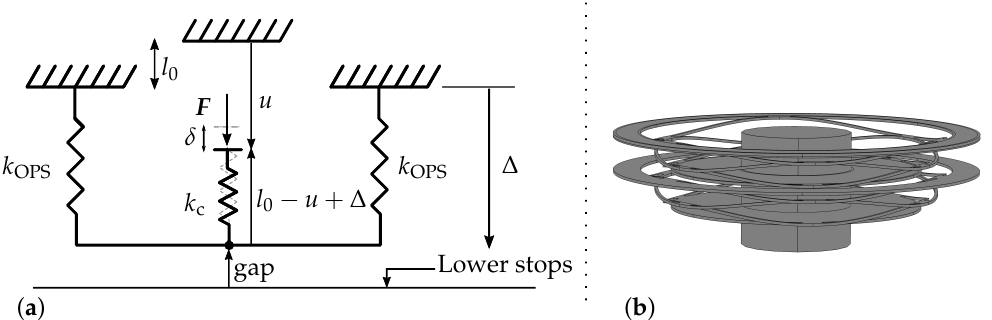
Figure 2. ( a ) Mechanical representation of the stiffnesses competition between the ortho-planar springs in parallel and the cavity. ( b ) Two elongated ortho-planar springs in parallel forming a linear guiding system. The outer boundary of the springs is